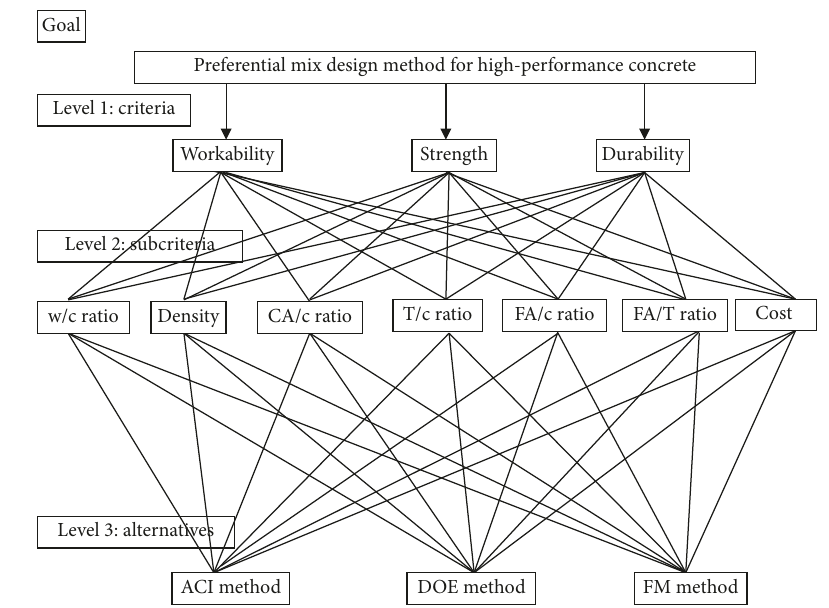
Figure 1: Hierarchical structure of the preferential mix design method and mix factors for high performance